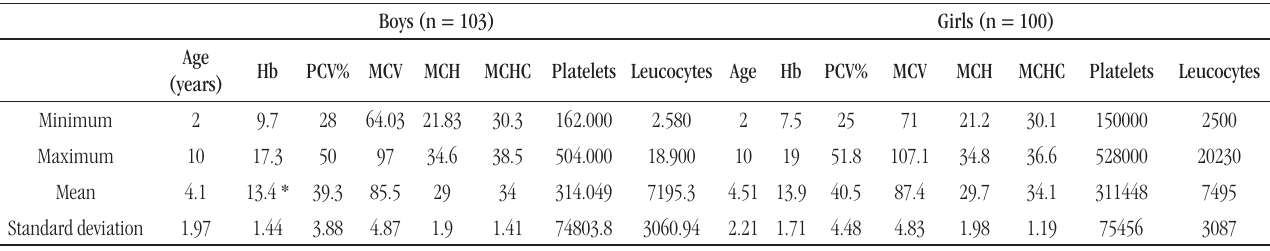
taBLE 2 − Hematological parameters in DS children, according to